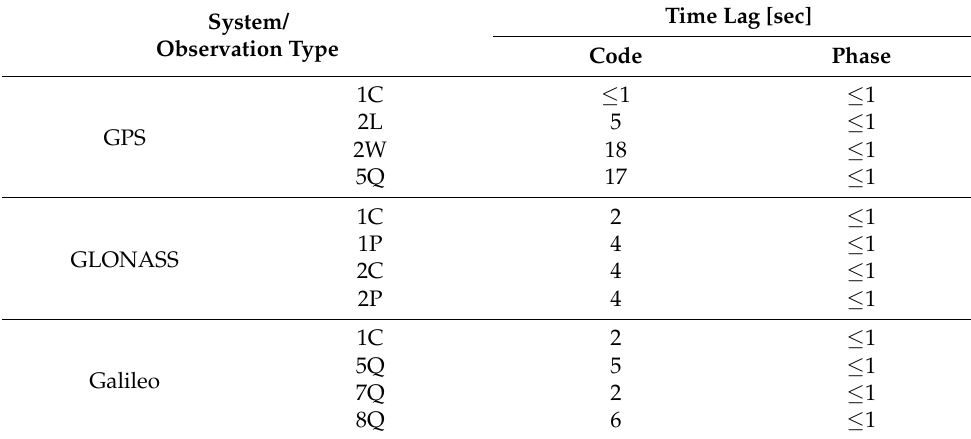
Table 3. Autocorrelation time lag for the analysis of a GNSS system for ρ t < 0.20 .